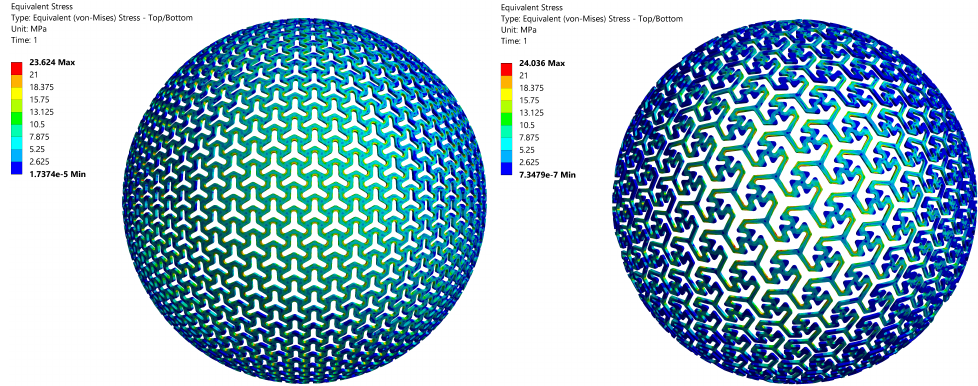
Figure 10. Von Mises stress fields corresponding to the applied force F = 250 N for Specimen A1 ( left ), respectively the applied force F = 50 N for specimen B1 ( right ), real thickness t r = 1.05